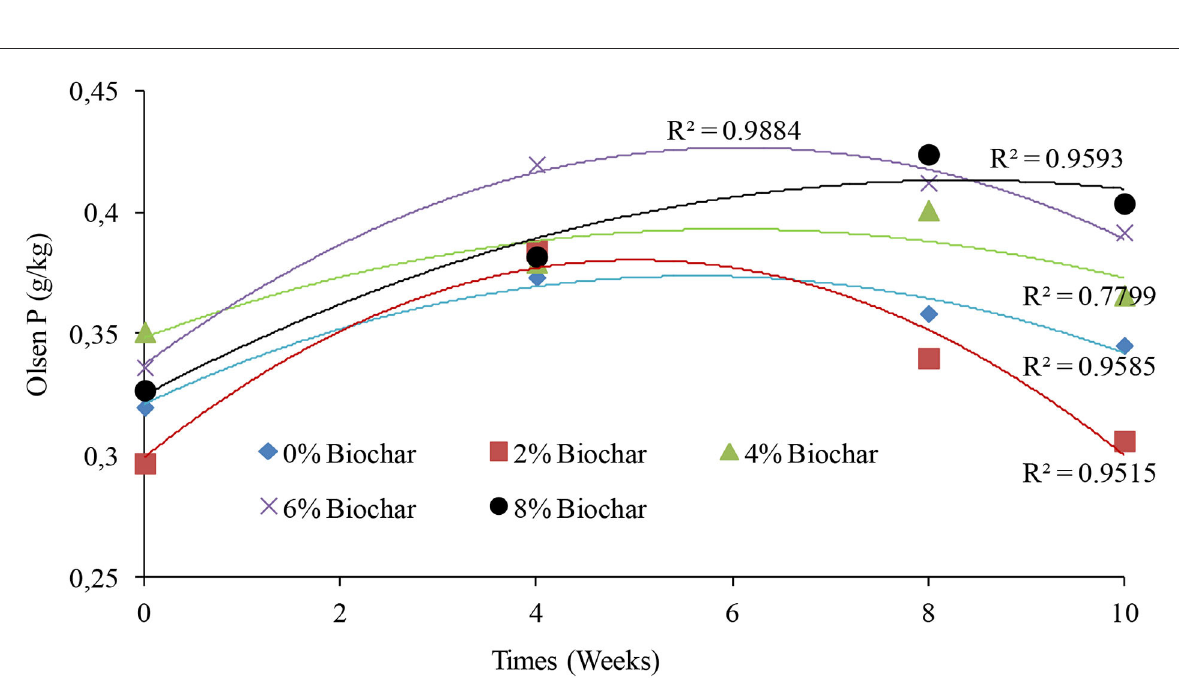
FIGURE5 Second-order polynomial line graphs showing the trends of changes in Olsen P after 10 weeks of vermicomposting of a goat manure–food waste mixture incorporated with seaweed ( G. funicularis )